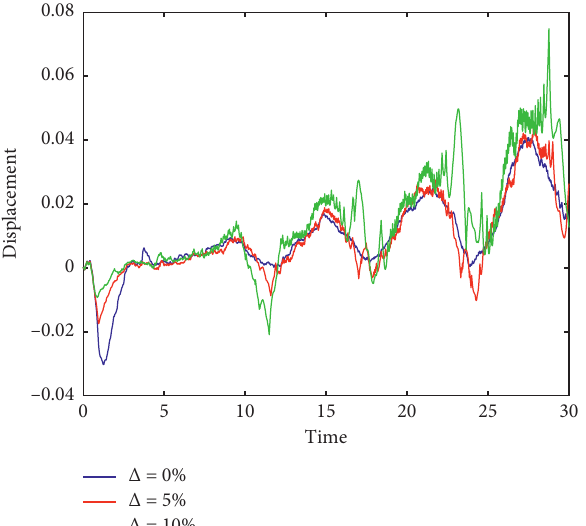
Figure 20: The horizontal displacement of 11 th story for the active system considering uncertainty with α � 0 . 2 and different values of Δ . (a) Δ � 5%. (b) Δ �